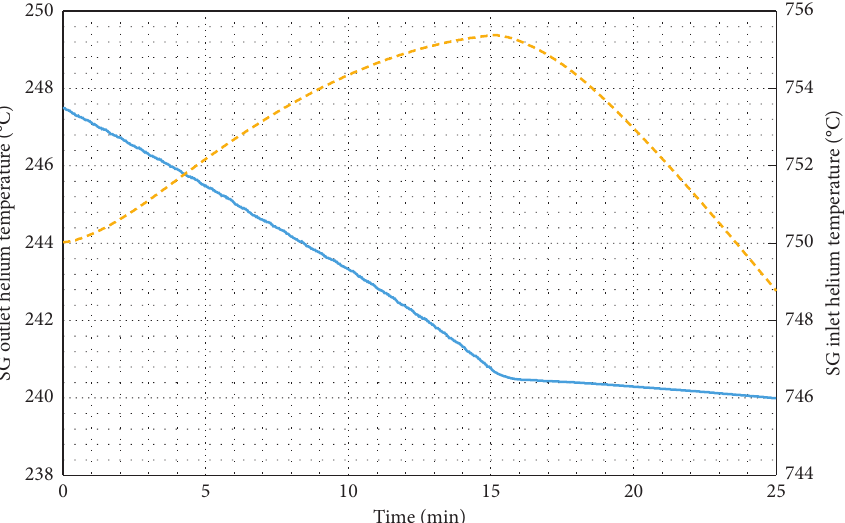
Figure 11: SG outlet and inlet helium temperature of #2 module in case 1 (solid line: outlet; dashed line: